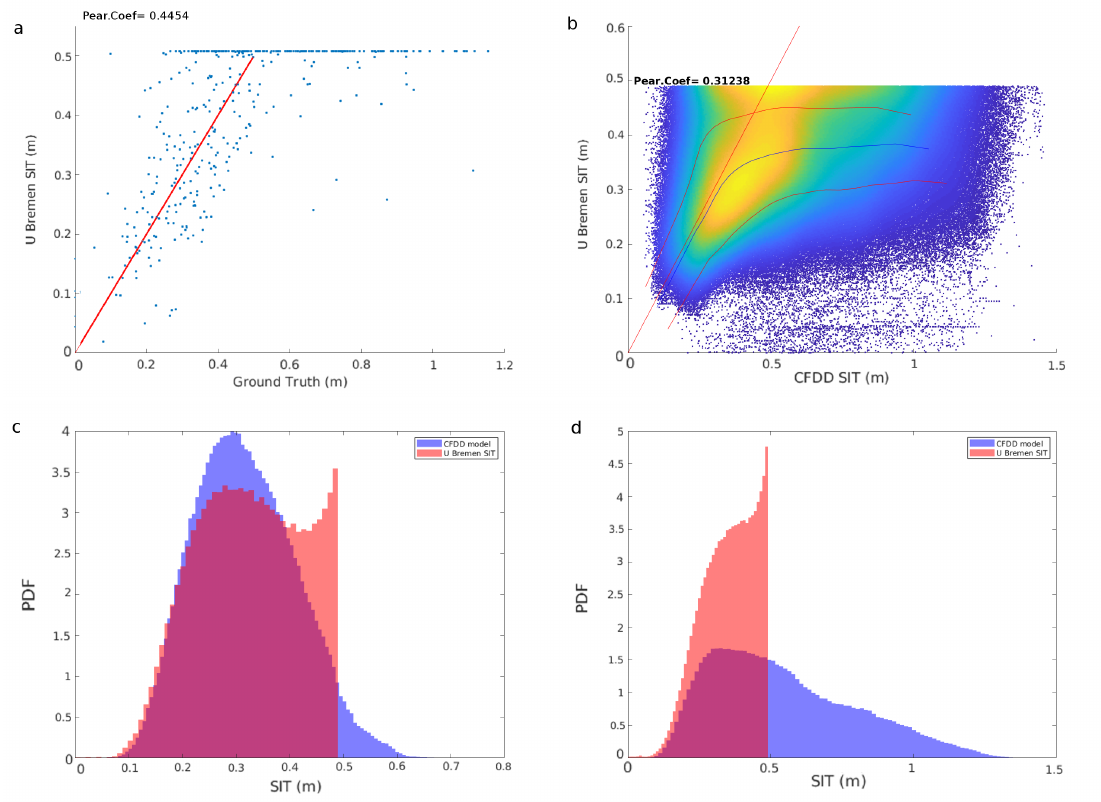
Figure 7. ( a ) Comparison between the ground truth measured by the upward looking sonar and the University of Bremen (UB) ice thickness. SMOS thickness uncertainty and saturation ratio are always below 1 m and 90% respectively. The red line represents the identity line. Ground truth was acquired for the freeze-up periods between 2010 and 2017. ( b ) Comparison between the modeled CFDD SIT and the UB ice thickness for the freeze-up periods between 2010 and 2017. SMOS thickness uncertainty and saturation ratio are always below 1 m and 90% respectively. The mean and standard deviations are depicted with a blue and red lines respectively. ( c ) PDFs of CFDD and UB SIT during October between the years 2010 and 2017. ( d ) PDFs of CFDD and UB SIT for the freeze-up periods between 2010 and 2017 with SIC over 90% in all